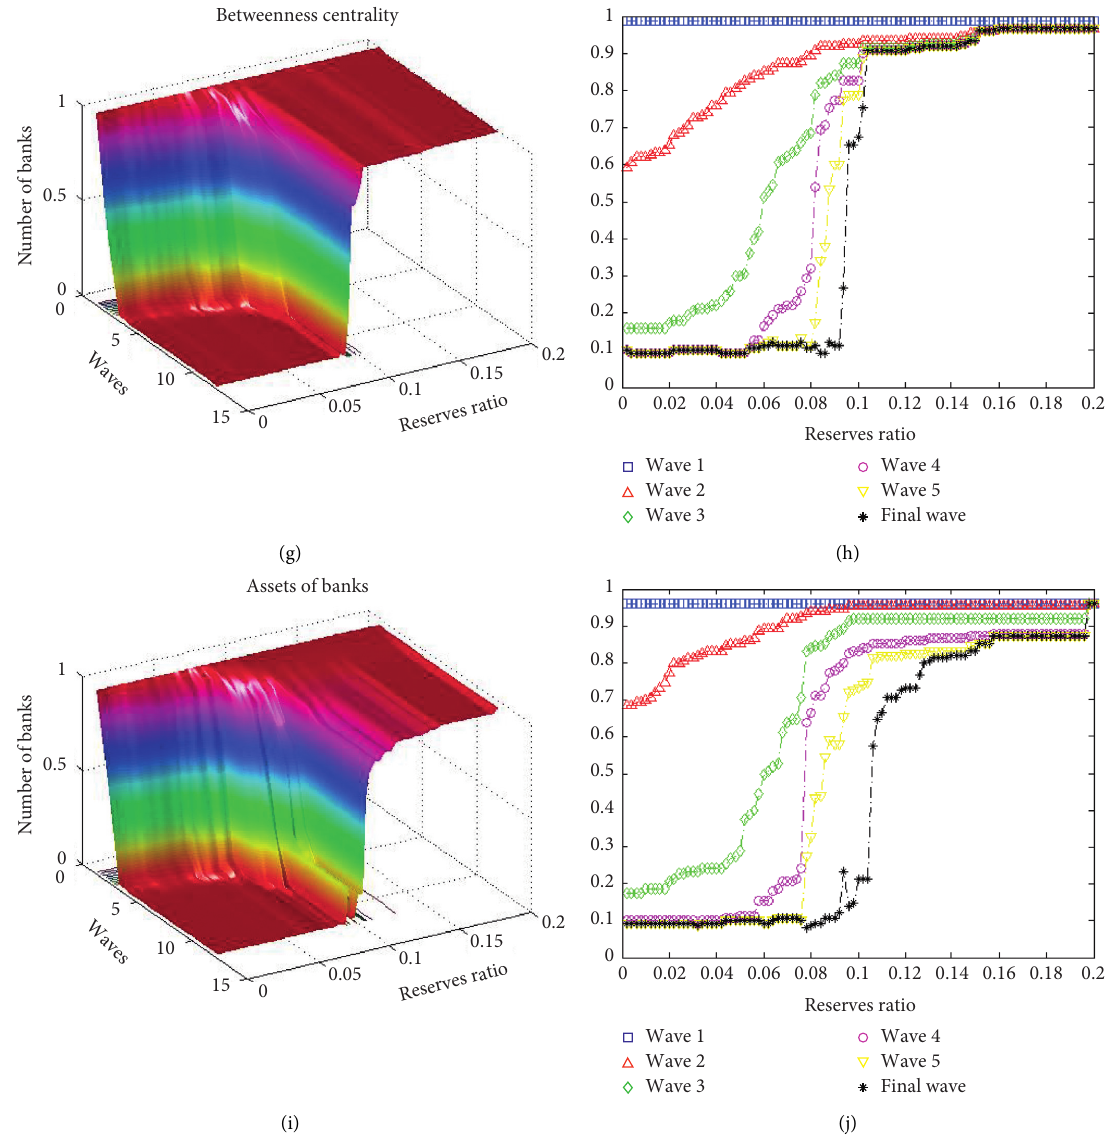
Figure 6: Impacts of the capital reserves ratio on the proportion of unaffected banks by financial contagion. The left panel shows the proportion of unaffected banks by financial contagion as a wave of cascading defaults and a function of the percentage of the reserves ratio (left panel). The right panel shows a cross-sectional view of the left panel in which the different colored dotted lines represent different waves of cascading defaults. We use 1000 Monte Carlo simulations to develop the networks with different types of targeted default